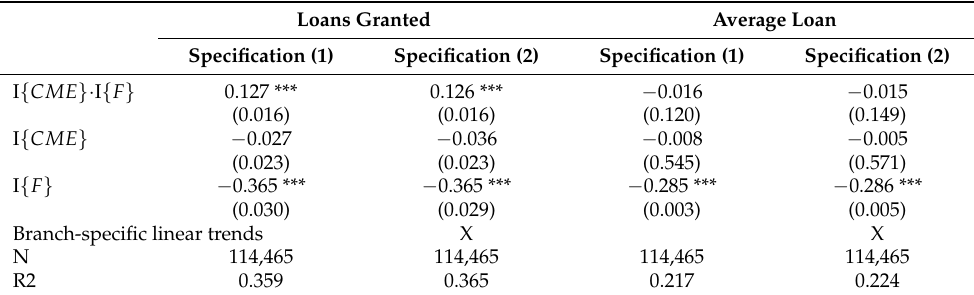
Table 5. The Effect of CME on Loans Granted and on Average Loan.